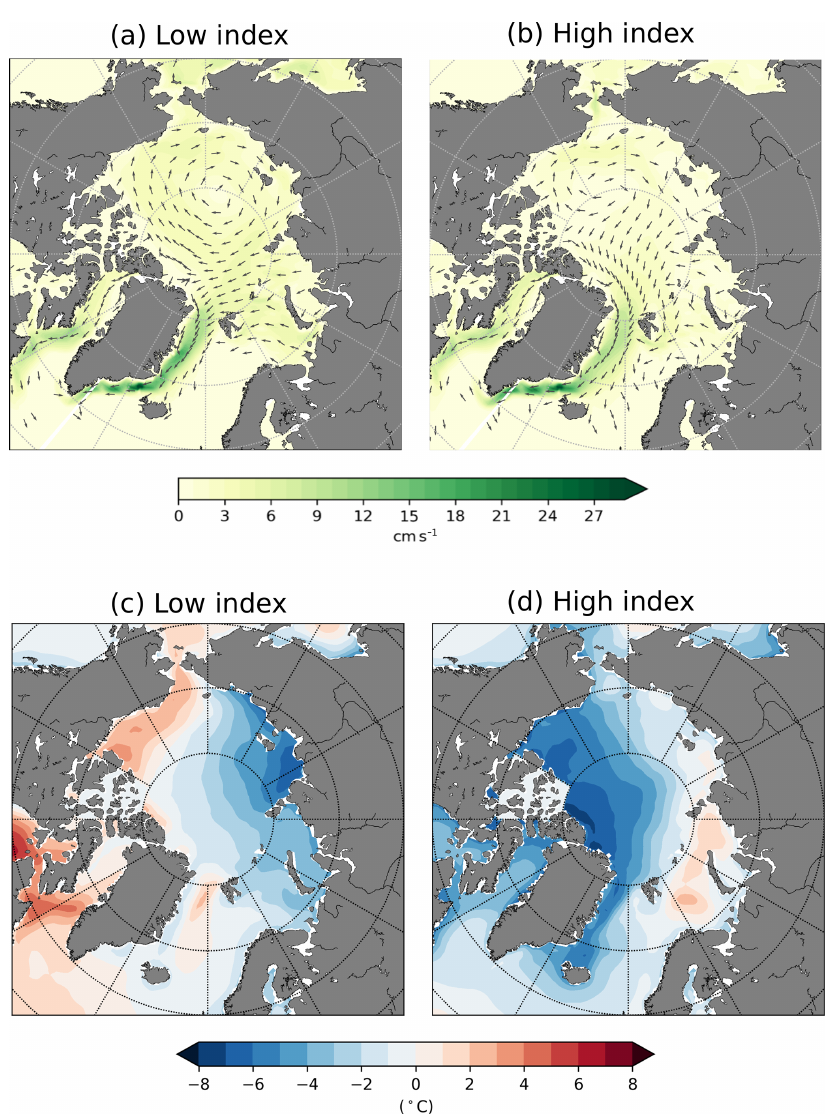
Figure 3. Arctic sea ice mean circulation during low (a) and high (b) indices of the first mode of SIT variability during the pre-industrial period. Arctic mean surface air temperature anomaly during low (c) and high (d) indices of the second mode of SIT